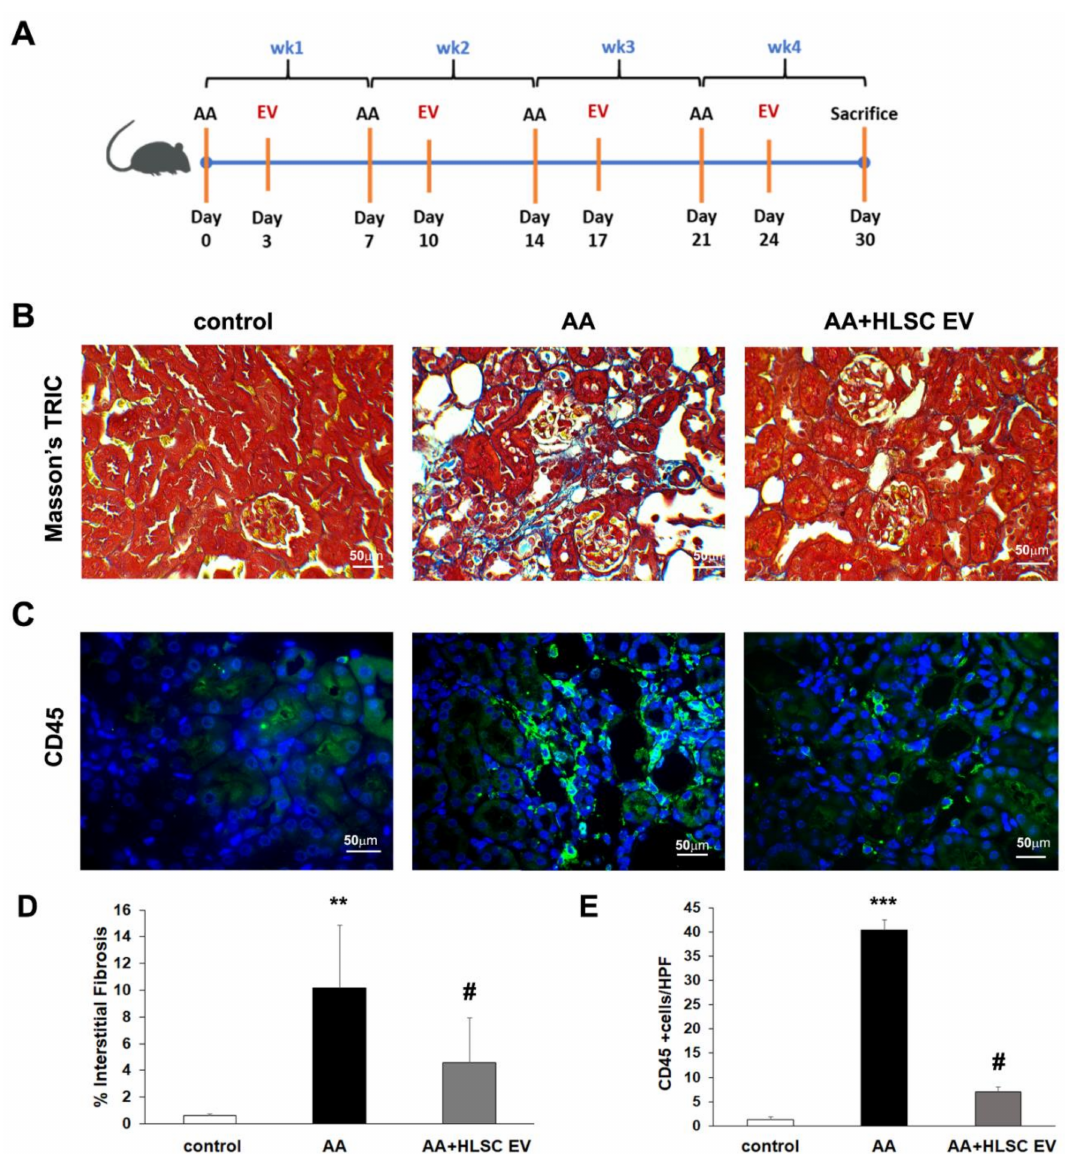
Figure 2. HLSC-EVs reduces fibrosis and inflammation in AAN. ( A ) Schematic representation of AAN in vivo model. ( B ) Representative micrographs of Masson’s trichome stained renal sections showing interstitial fibrosis (blue stain; scale bar = 50 µ m). ( C ) Representative immunofluorescence images showing increased expression of CD45 in AAN mice and downregulation following treatment with HLSC-EVs. ( D ) Histological quantification of interstitial fibrosis by multiphase image analysis of 10 fields per section. Data represent mean ± SD; one-way ANOVA. ** p < 0.01 AA vs. control, # p < 0.01 AA+HLSC EV vs. AA. (n = 5 mice for control and AA, and n = 9 mice for AA+HLSC EV). ( E ) Histogram depicting the number of cells positive for CD45 in FFPE sections of in vivo experimental groups. Data represent mean ± SD of the number of cells positive per HPF (high power field) measure from 10 images (n = 5 mice per group). *** p < 0.0001 AA vs. control and # p < 0.01 AA+HLSC EV vs.